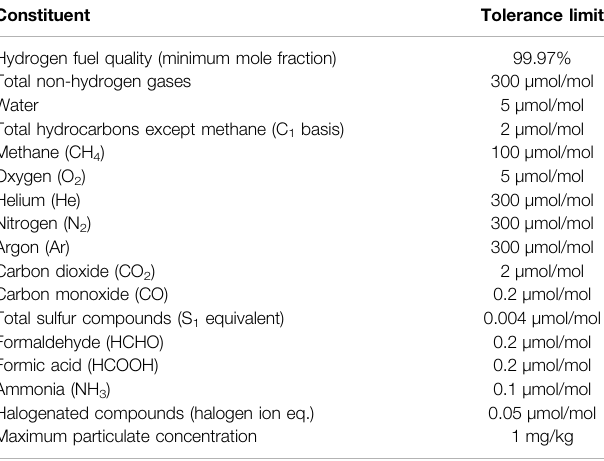
TABLE 1 | Hydrogen fuel tolerance limits as given by ISO/FDIS 14687.